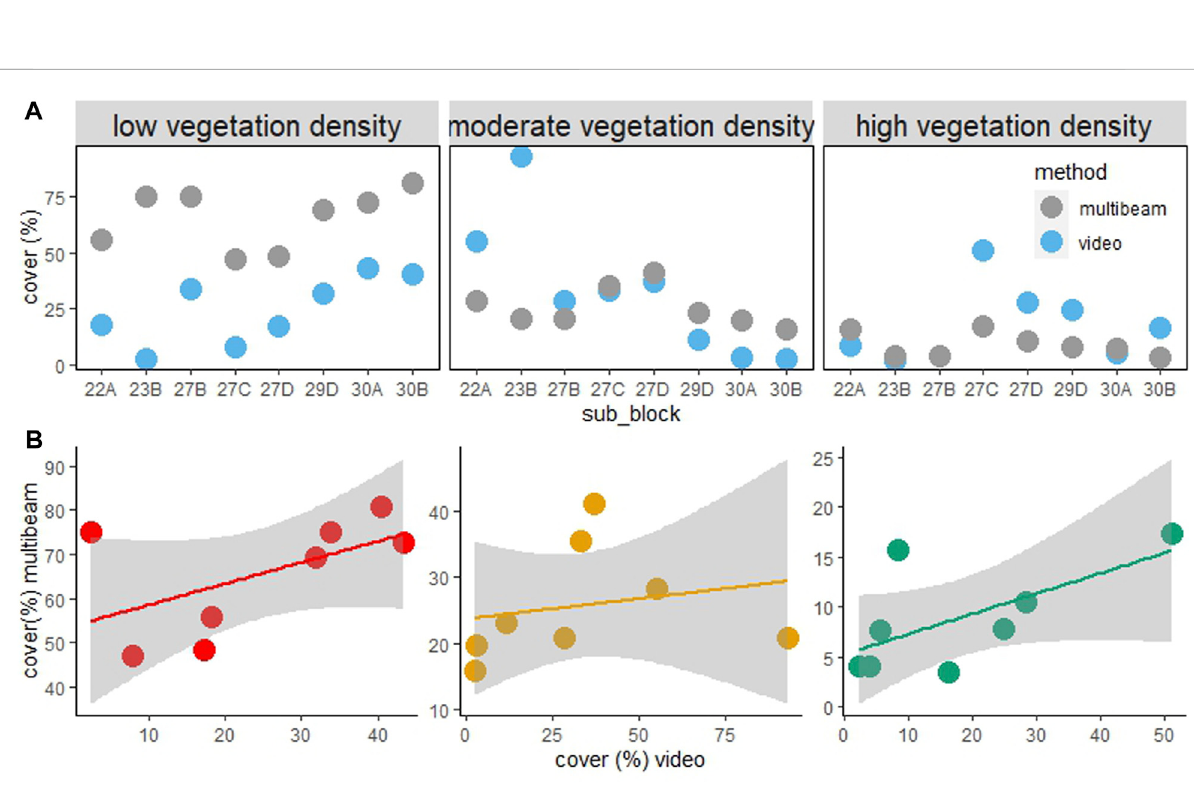
FIGURE 7 %of reef 5 – 25 m covered bythree algal canopy densities across species determined byvideo and acoustic water column data. (A) is% cover across fi sheries management subblocks and (B) is the correlation plots comparing estimates derived from the two survey methods. Low, moderate, and high algal densities represent algal cover of 0 – 20, 20 – 60, and > 60% respectively determined by video analysis, and signal strengths of − 64 to − 60 db, − 60 to 50, and > − 50 respectively determined by the acoustic water column (multibeam)